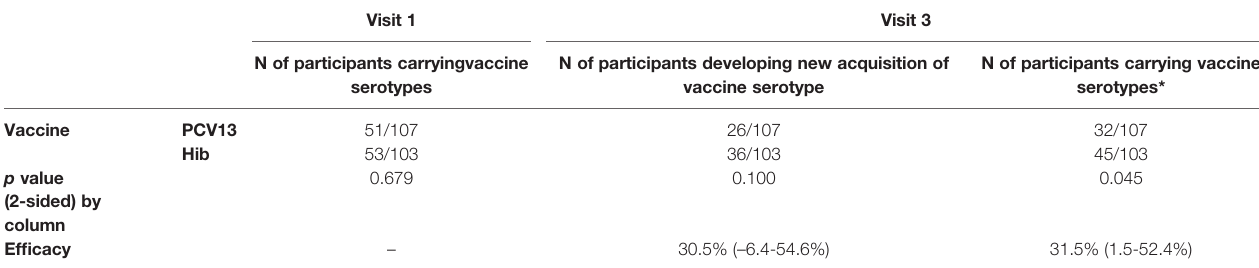
TABLE 3 | Within and between group comparisons of pneumococcal vaccine serotype carriage.